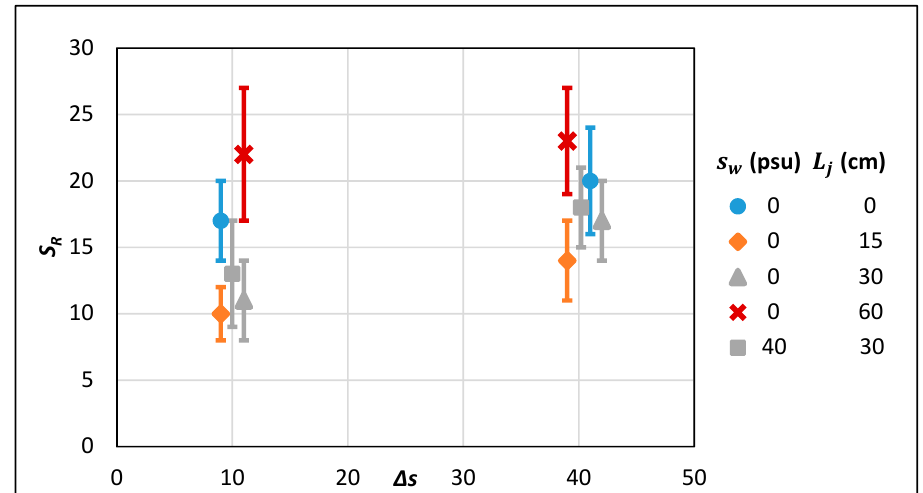
Figure 6. Dilutions measured along the bottom of the tank at R = 50 cm plotted against ∆ s . (The abscissas of various measurements are shifted slightly so that all symbols are visible.).